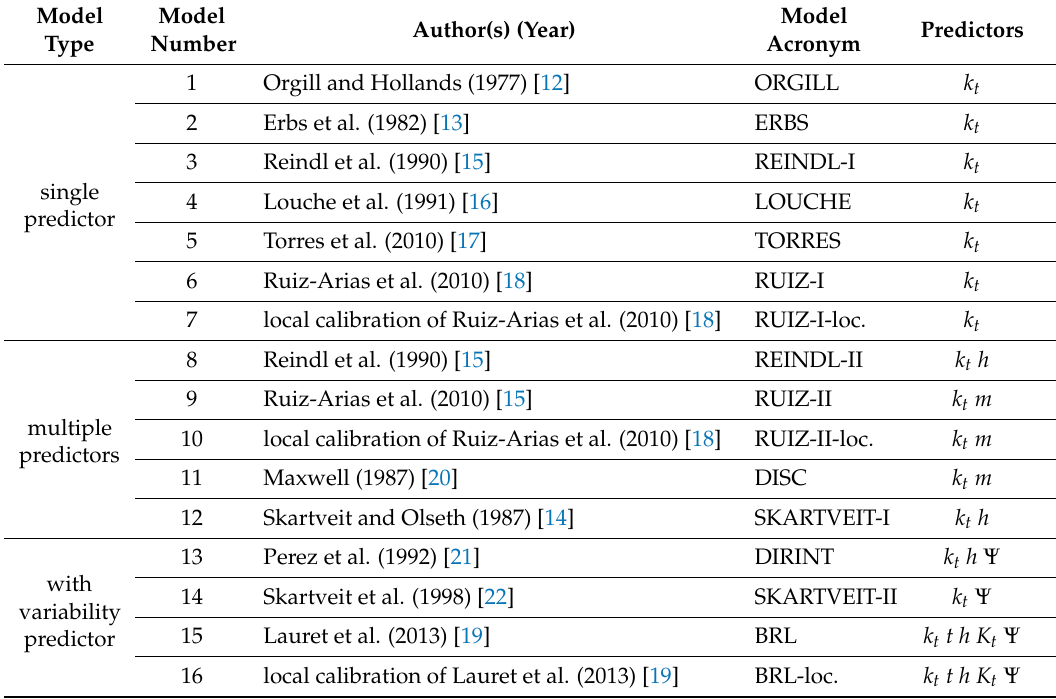
Table 1. List of the decomposition models, associated model numbers, literature references, acronyms and predictors used (hourly clearness index: k t , local apparent time: t , solar elevation: h , daily clearness index: K t , variability/persistence index: Ψ